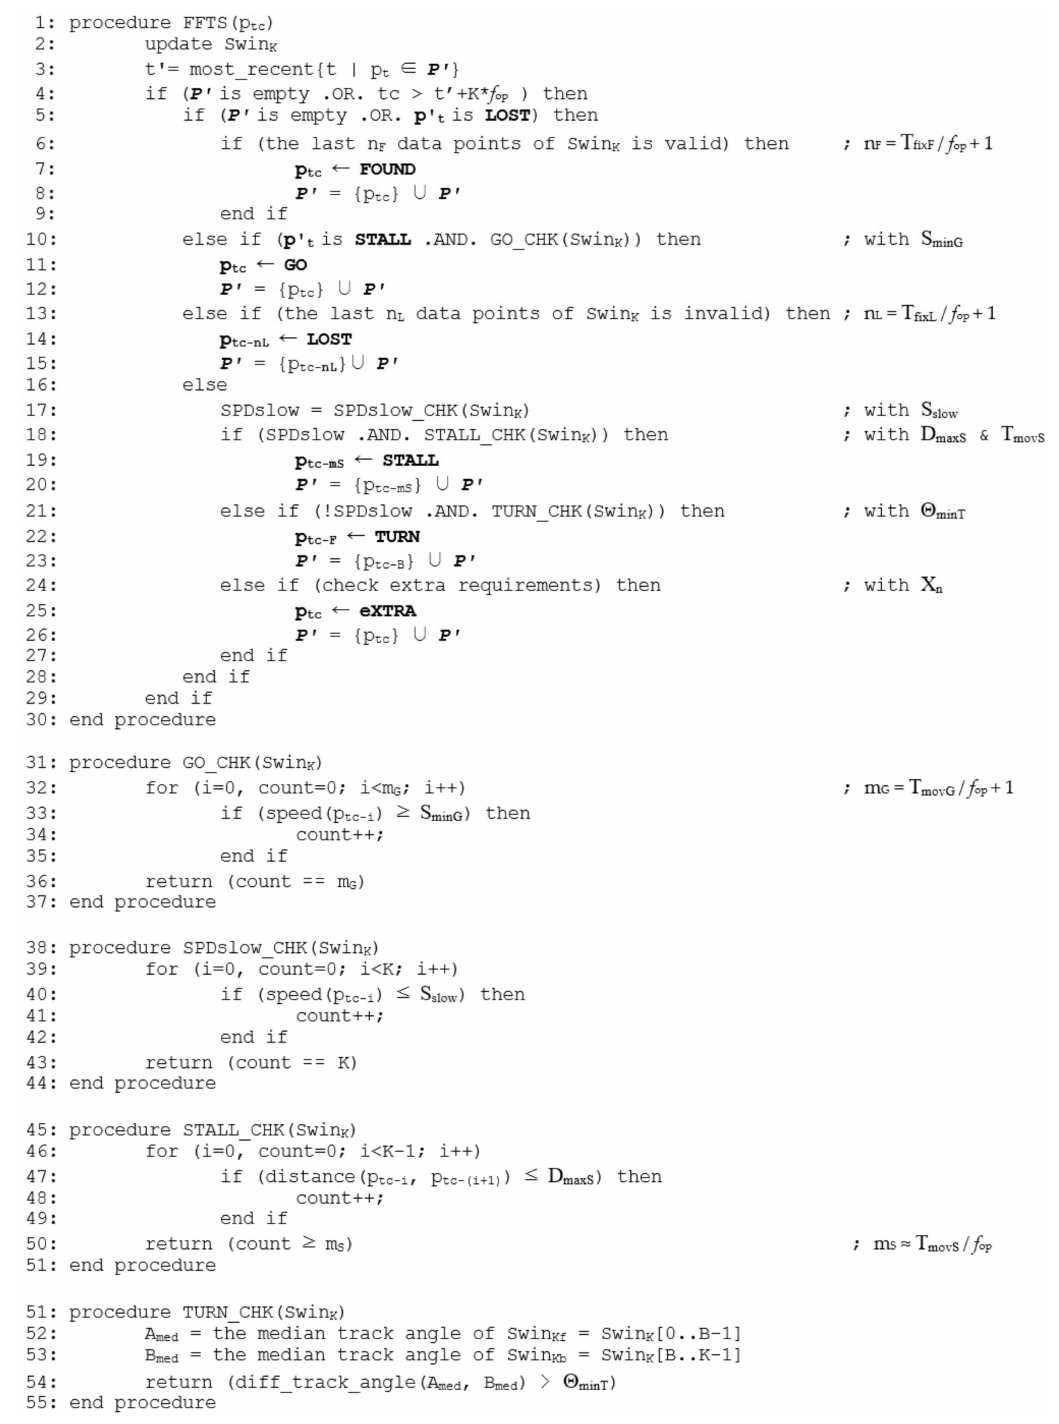
Figure 2. The feature-first trajectory simplification